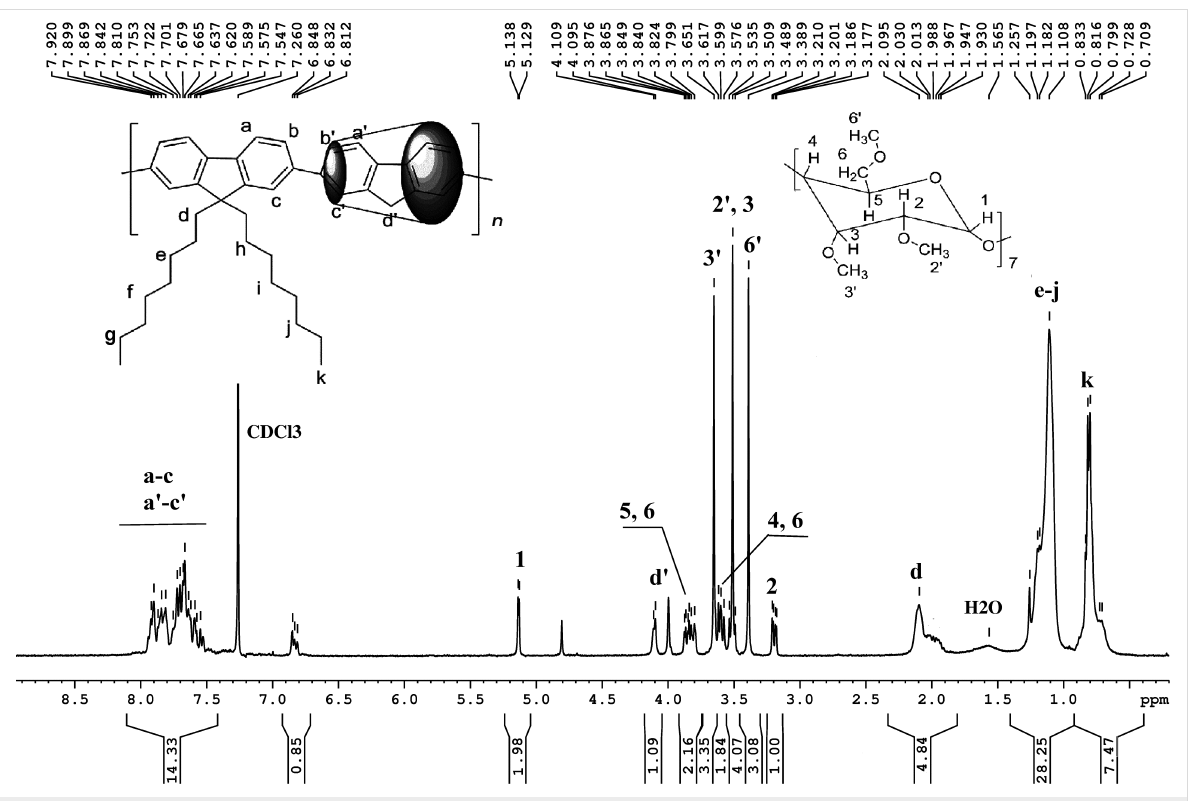
Figure 1: 1 H NMR spectrum of the polyrotaxane 3·TM- β CD copolymer in CDCl 3 .